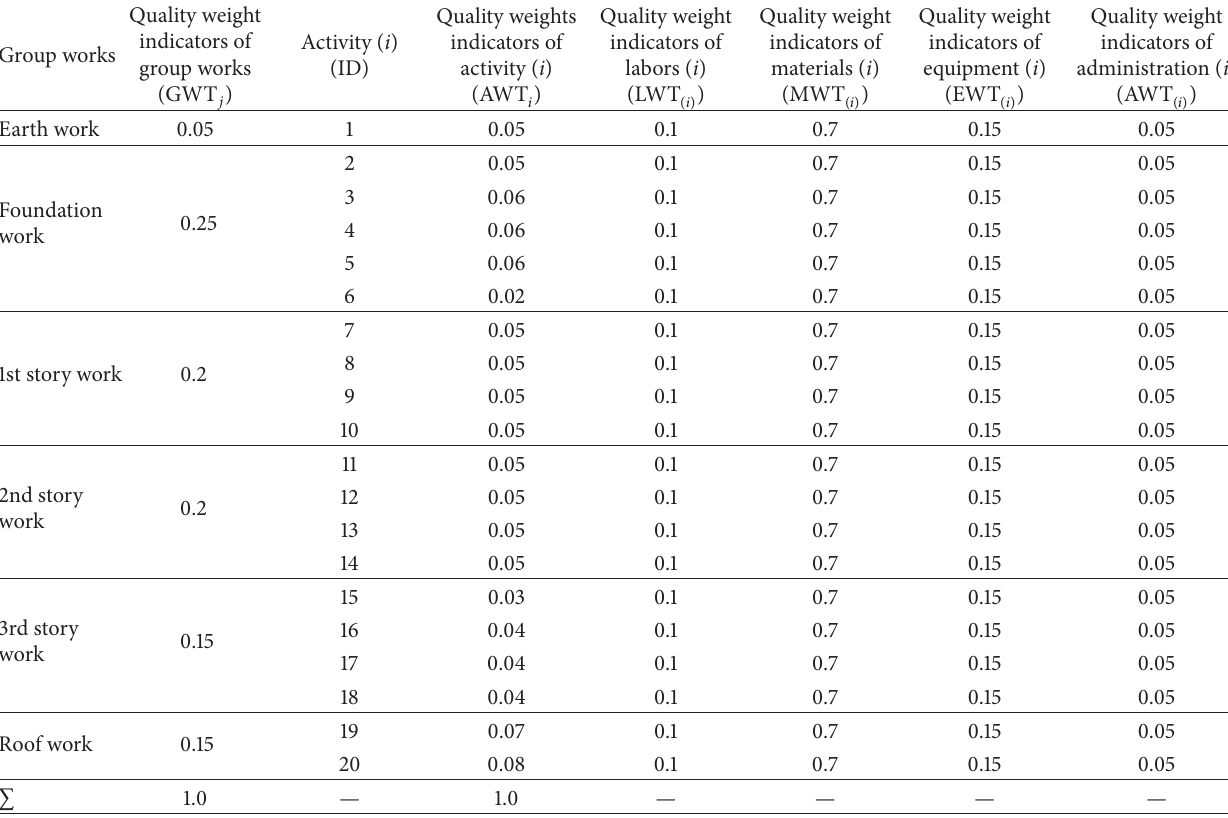
Table 2: The quality weight indicators.